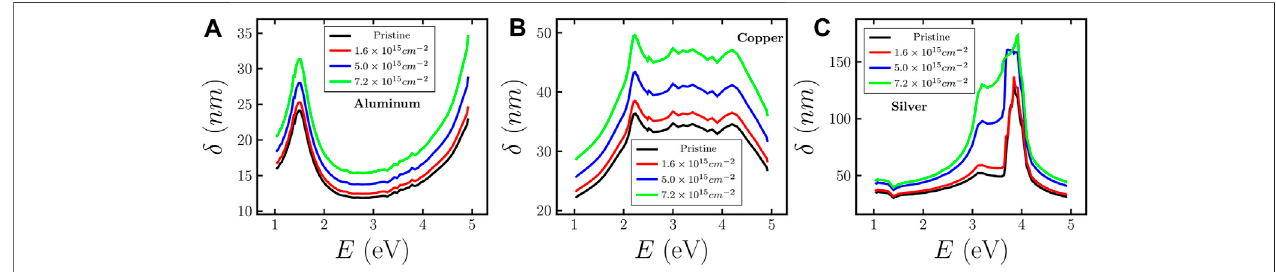
FIGURE 5 | Variation of skin depth for (A) aluminum, (B) copper, and (C) silver, respectively, with energy of incident light as well as varying fl uence of Argon